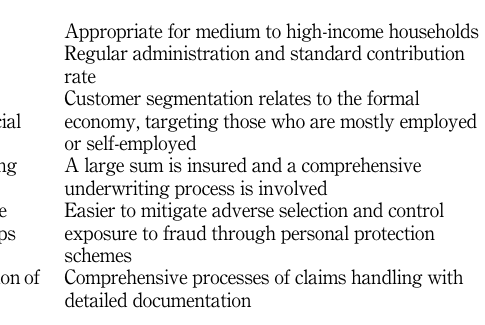
Table 1. Comparison between Micro- Tak (cid:1) aful and Tak (cid:1) aful